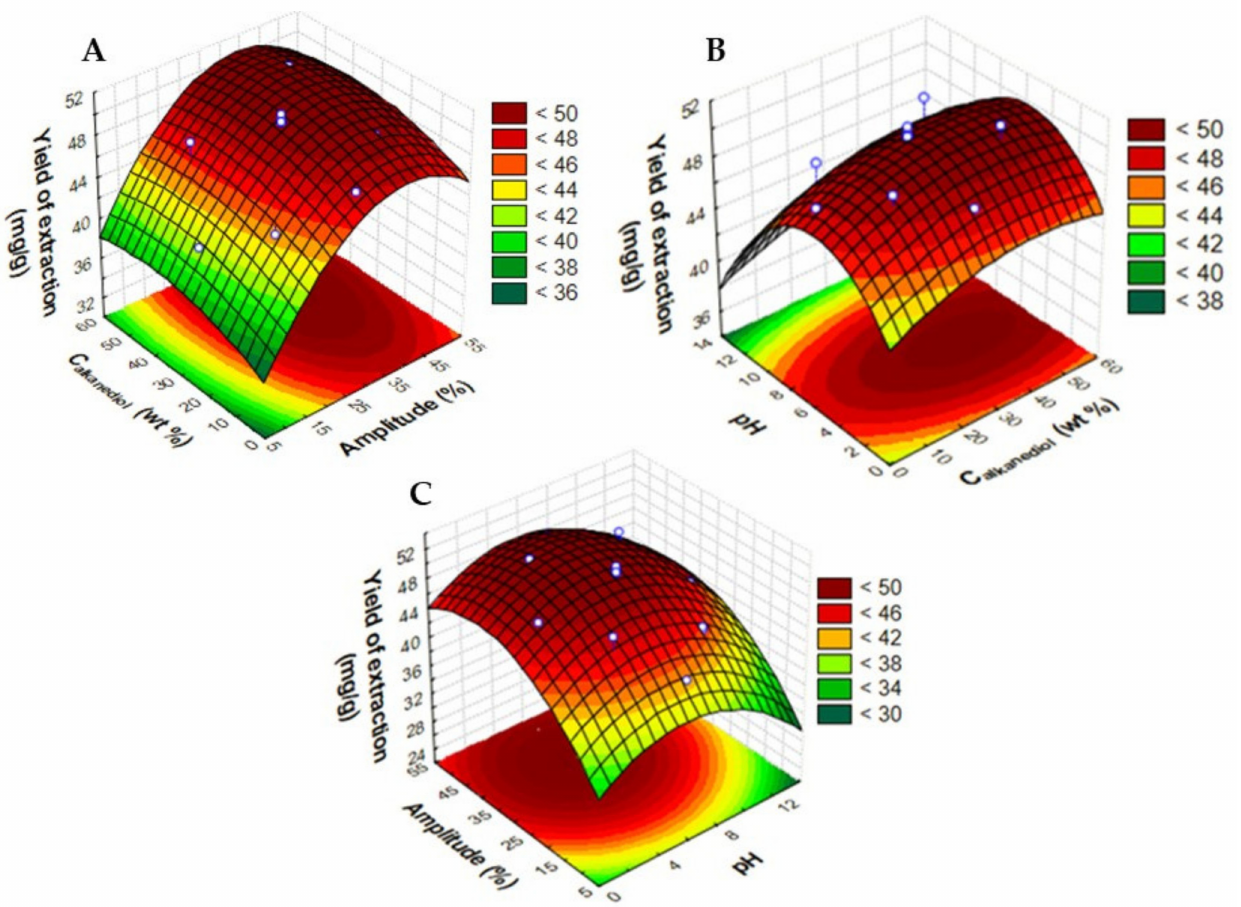
Figure 2. Response surface plots obtained for the CCRD (2 3 ) regarding the application of UAE, considering the alkanediol concentration (C alkanediol in wt%), amplitude (%), and pH in terms of yield of extraction of anthocyanins (mg anthocyanins · g dry biomass − 1 ). ( A ) C alkanediol and Amplitude, ( B ) pH and C alkanediol , and ( C ) Amplitude and